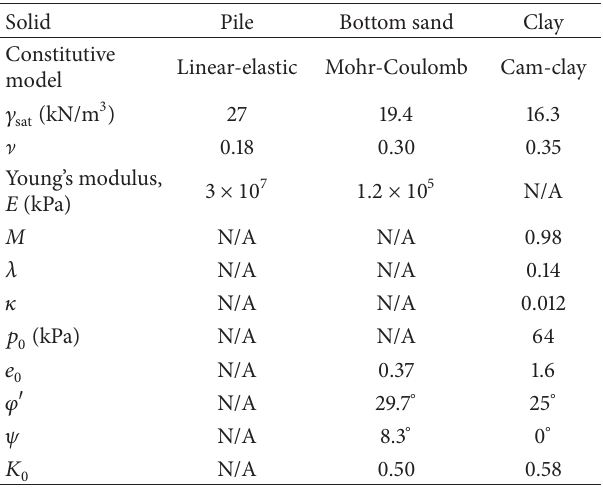
Table 2: Constitutive models and material parameters adopted for the numerical